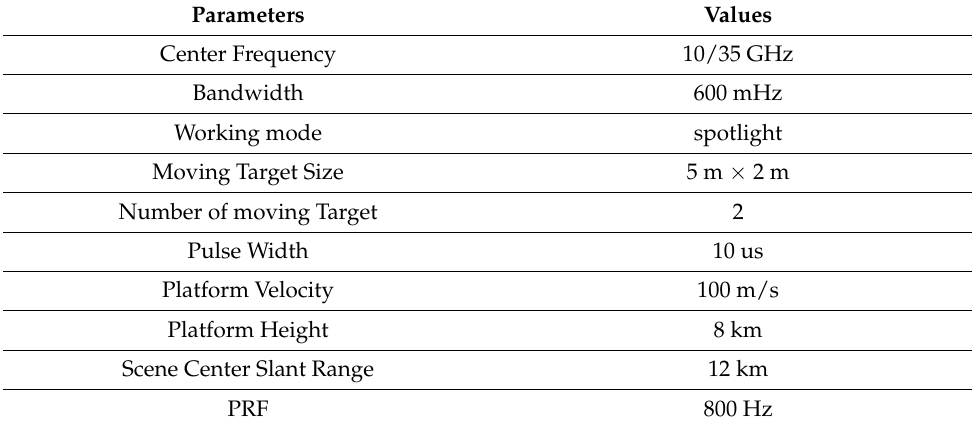
Table 2. Simulation